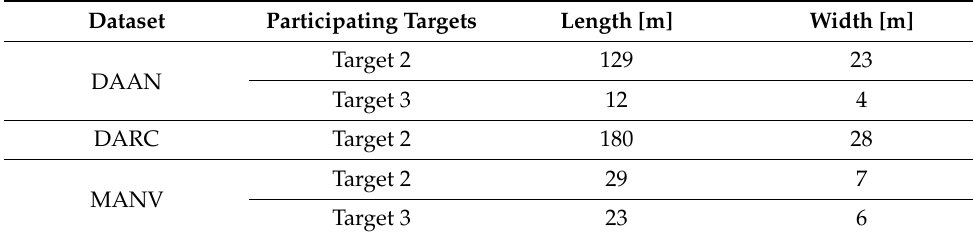
Table 2. Dimensions of vessels for the different